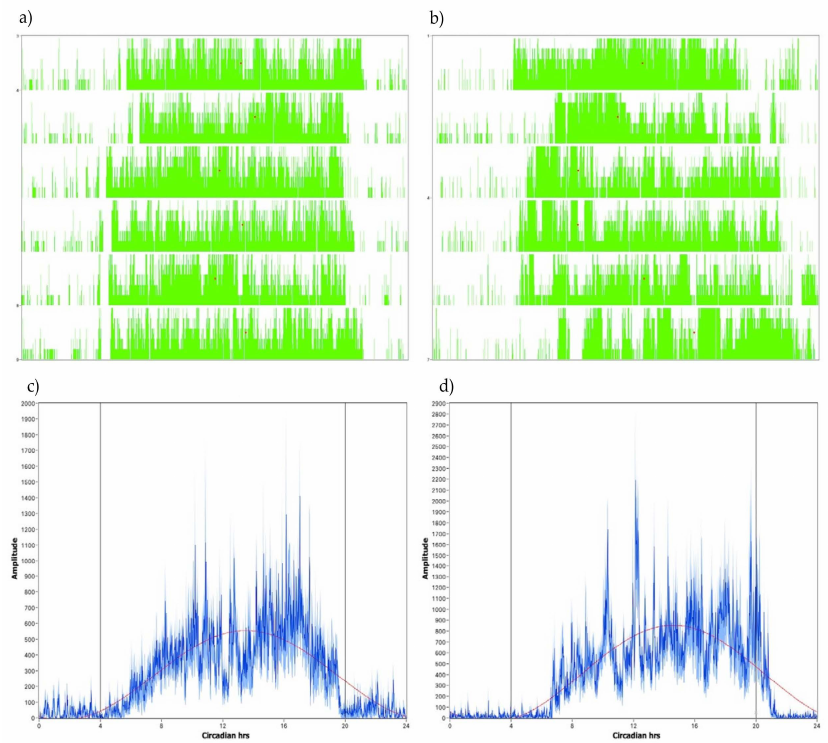
Figure 1. Representative actograms and activity profiles. ( a ) 6-day actogram (1 row per day) of activity counts for a 15-year-old with DS, showing relatively consistent onsets, offsets, and acrophases (acrophases noted with red dots as the midpoint of daily activity). ( b ) 6-day actogram (1 row per day) of activity counts for a 15-year-old with TD, showing a wider range of variation in onsets, offsets and acrophases (noted with red dots). ( c ) 24-h activity profile of 6-year-old with DS, showing the consolidation of waking (higher amplitude) versus sleeping times (lower amplitude). ( d ) 24-h activity profile of a 6-year-old with TD, also showing sleep and wake